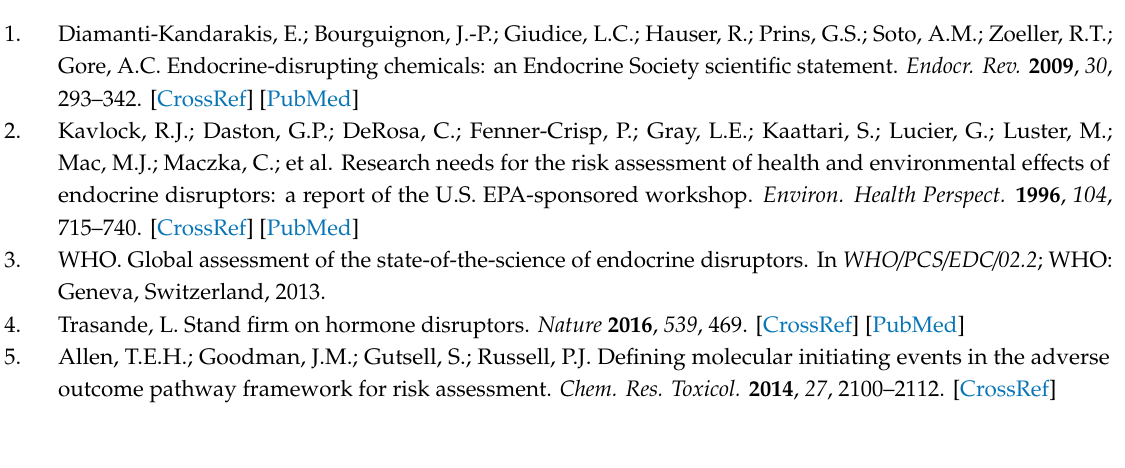
Table S1: 1046 US-approved and marketed drugs with Endocrine Disruptome (ED)-predicted binding to respective nuclear receptors and Table S2: